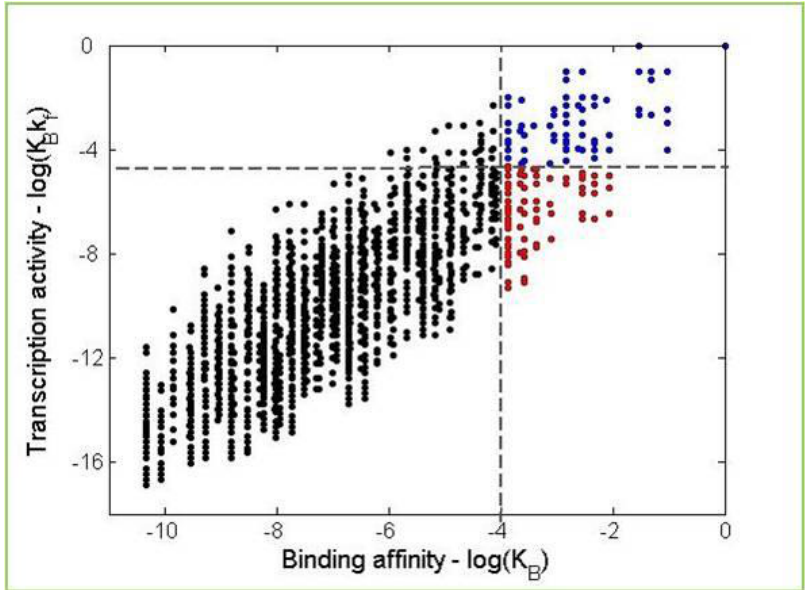
  log    log K ) for the Figure 2: Log transcription rate ( ) vs. log binding affinity ( B intergenic segments. -10 element of lacUV5 promoter is substituted by all 6bp long segments   log K and   log  are calculated for each of these from E. coli intergenic regions. B substitutions and shown, respectively, on the horizontal and the vertical axes on each of the panels. The horizontal and the vertical dashed lines correspond, respectively, to the transcription rate threshold and the binding affinity threshold. Green and red dots in the figure correspond to the strongly bound DNA sequences that are, respectively, functional promoters and poised promoters. Figure adapted from